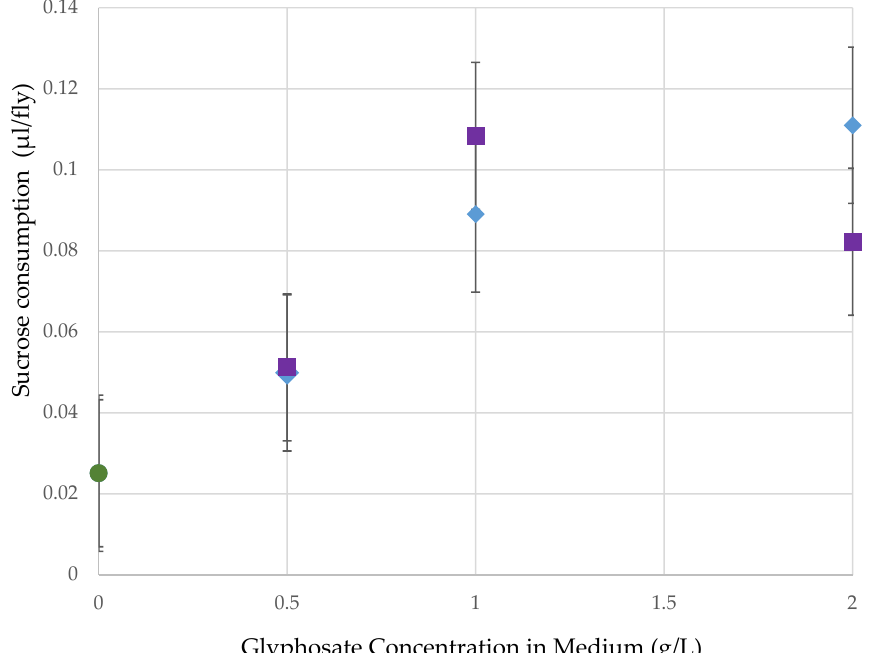
Figure 3. Of the total 1814 flies, there was an increase in organic sucrose consumption as the concentration of glyphosate in the pre-treatment medium increased ( p = 0.001). There was no difference between the two formulations. = organic control, (cid:3) = Roundup Ready to Use (glyphosate + pelargonic acid), (cid:35) = Roundup Super Concentrate (glyphosate with POEA). (cid:51)